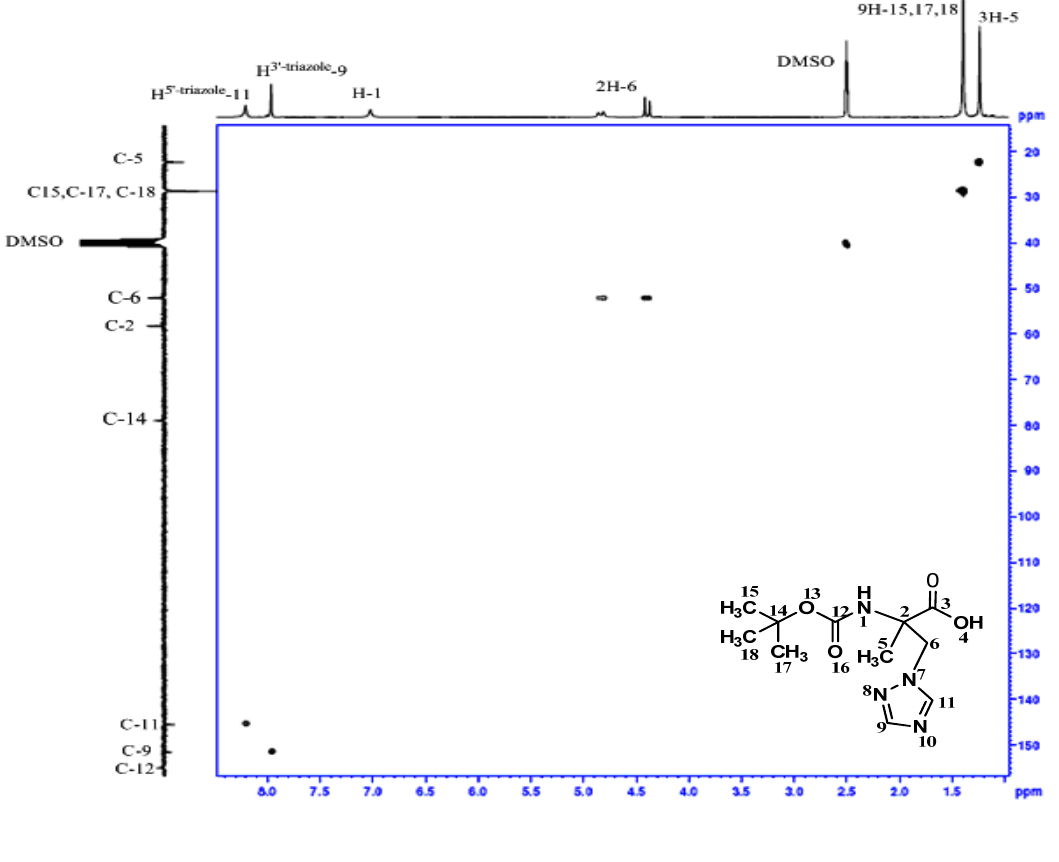
Figure 4. Heteronuclear 1 H- 13 C 2D spectrum for compound 5